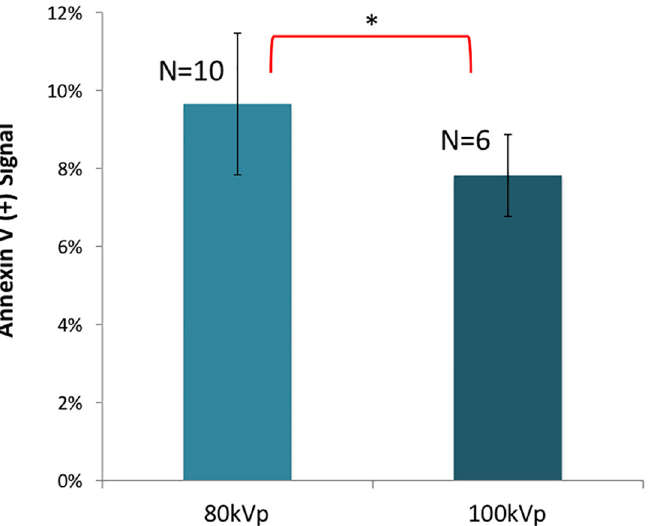
Fig 5. An X-PACT effect in 4T1-her2 is observed at both 80 and 100kVp, with suggestion that 80 kVp may be slightly more effective than 100 kVp (p = 0.011). This data acquired from X-PACT treatment of 4T1-HER2 cells with constant phosphor concentration of 50 μ g/mL and UVADEX diluted to 8-MOP concentration of 10 μ M (1:10 dilution). N is the number of independent measurements.